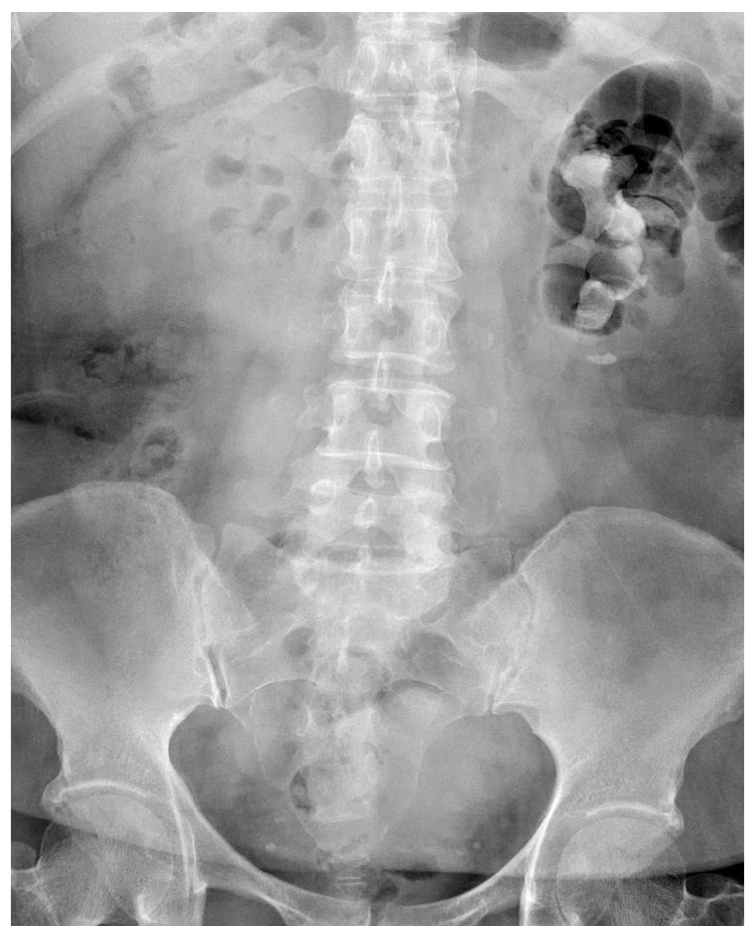
Figure 1. Preoperative findings of a kidney, ureter and bladder radiograph that were suggestive